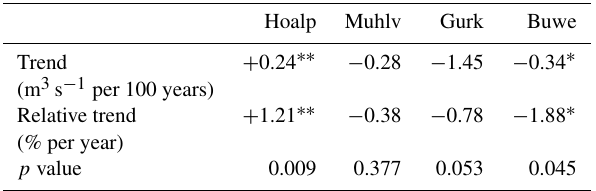
Table 1. Trend estimates of observed Q 95 low flows in the period 1976–2008 (Mann–Kendall test). Relative trends refer to the trend over the observation period relative to its